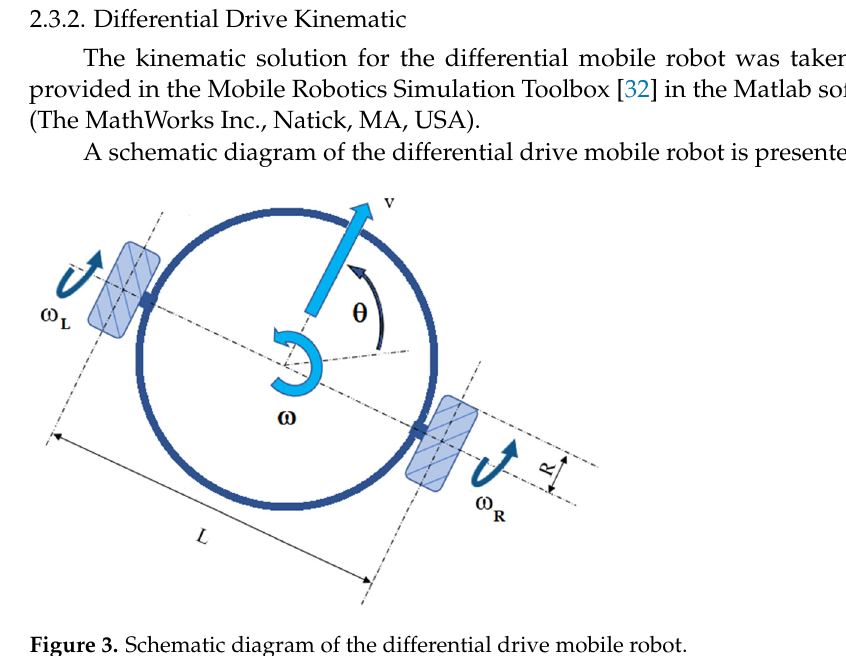
Figure 3. Schematic diagram of the differential drive mobile robot. According to [32], the inputs of the kinematic model are the left and right wheel speeds, ω L and ω R (in rad/s), while the outputs are the linear velocity v (in m/s) and the angular velocity ω (in rad/s).